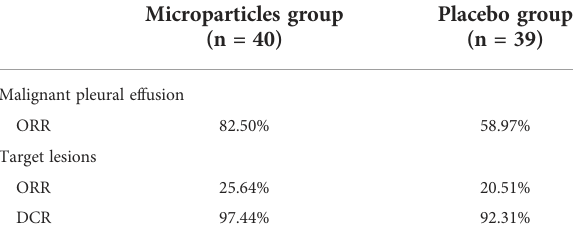
TABLE 2 Ef fi cacy of malignant pleural effusion and target lesions.